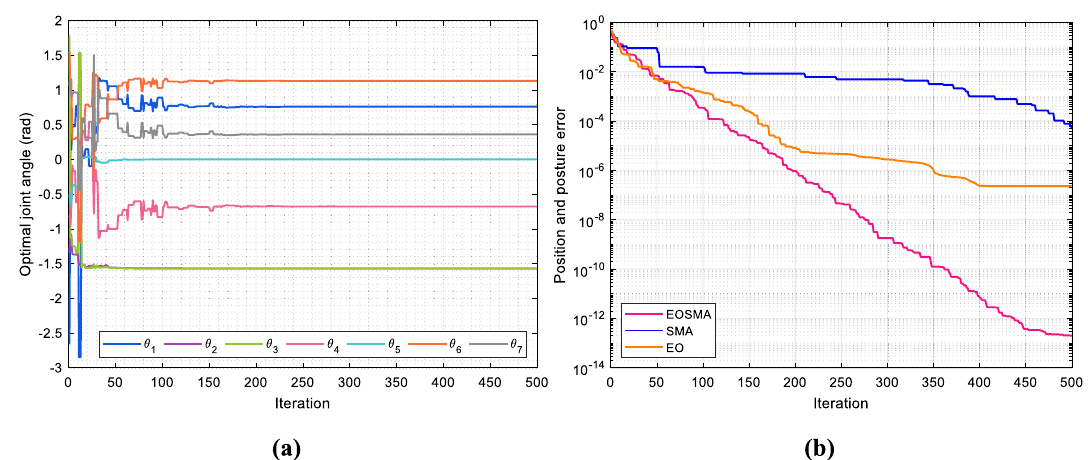
Figure 19. Optimization process of the algorithm. ( a ) Optimal candidate joint angle of EOSMA varies with the number of iterations. ( b ) Convergence curve of the